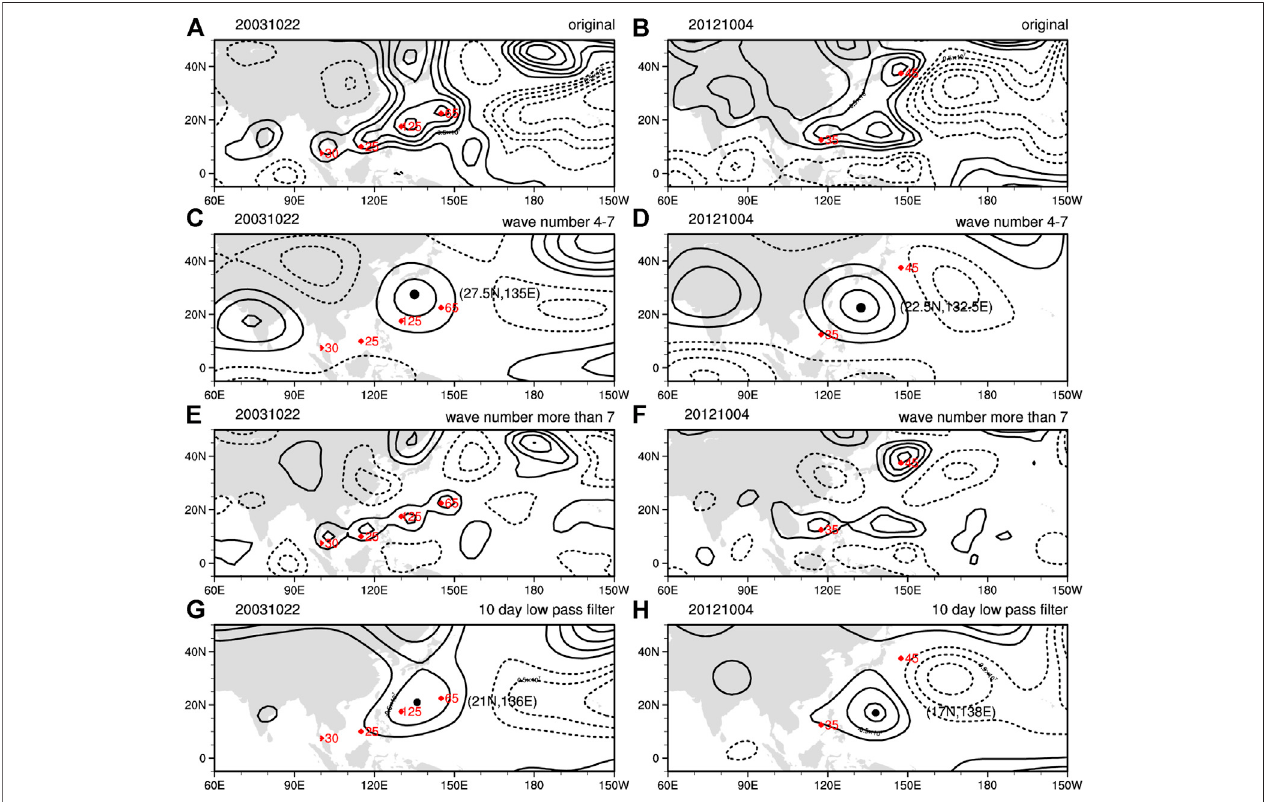
FIGURE1| ExamplesofseparatingMGandTCsbyspatial fi lteringmethodwithasphericalharmonicexpansionandLanczostime fi lteringmethodon (A) , (C) , (E) , (G) October22,2003and (B) , (D) , (F) , (H) October4,2012 (A) and (B) aretheoriginalstreamfunction fi eldsat850 hPa (C) and (D) arestreamfunction fi eldsat 850 hPa with wavenumbers 4 – 7 (E) and (F) are streamfunction fi elds at 850 hPa with wavenumbers larger than 7, and (G) and (H) are streamfunction fi elds at 850 hPa obtained bythetime fi lteringmethod.ThereddotsareTCcentersfromtheJTWC,therednumbersarethe1 minaveragesustainedwindspeeds,andtheblackdotsarethe MG circulation